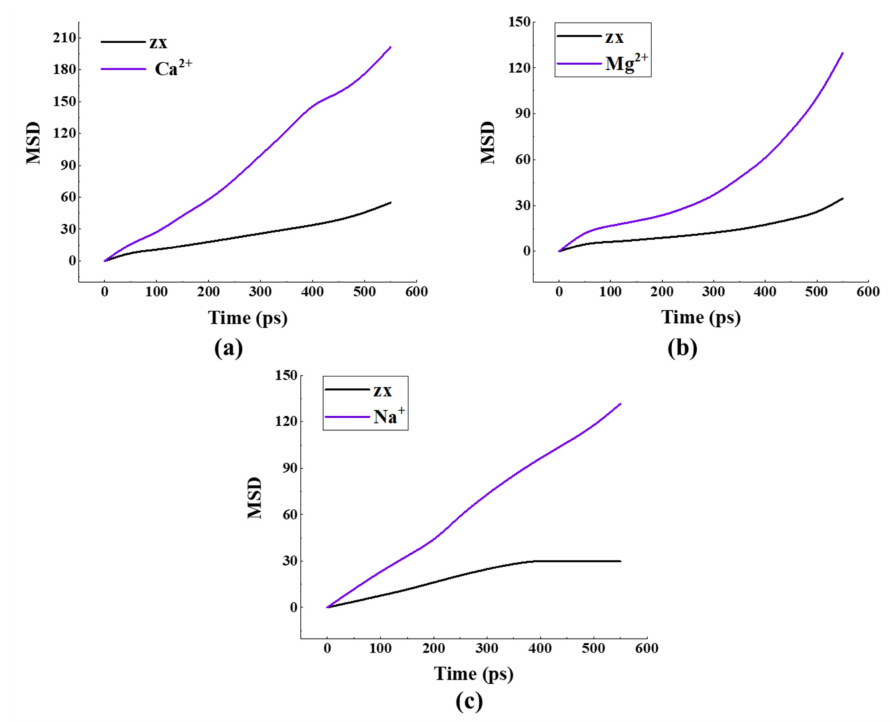
Figure 8. MSD of surfactant head groups and cations surrounding the head groups in different APG